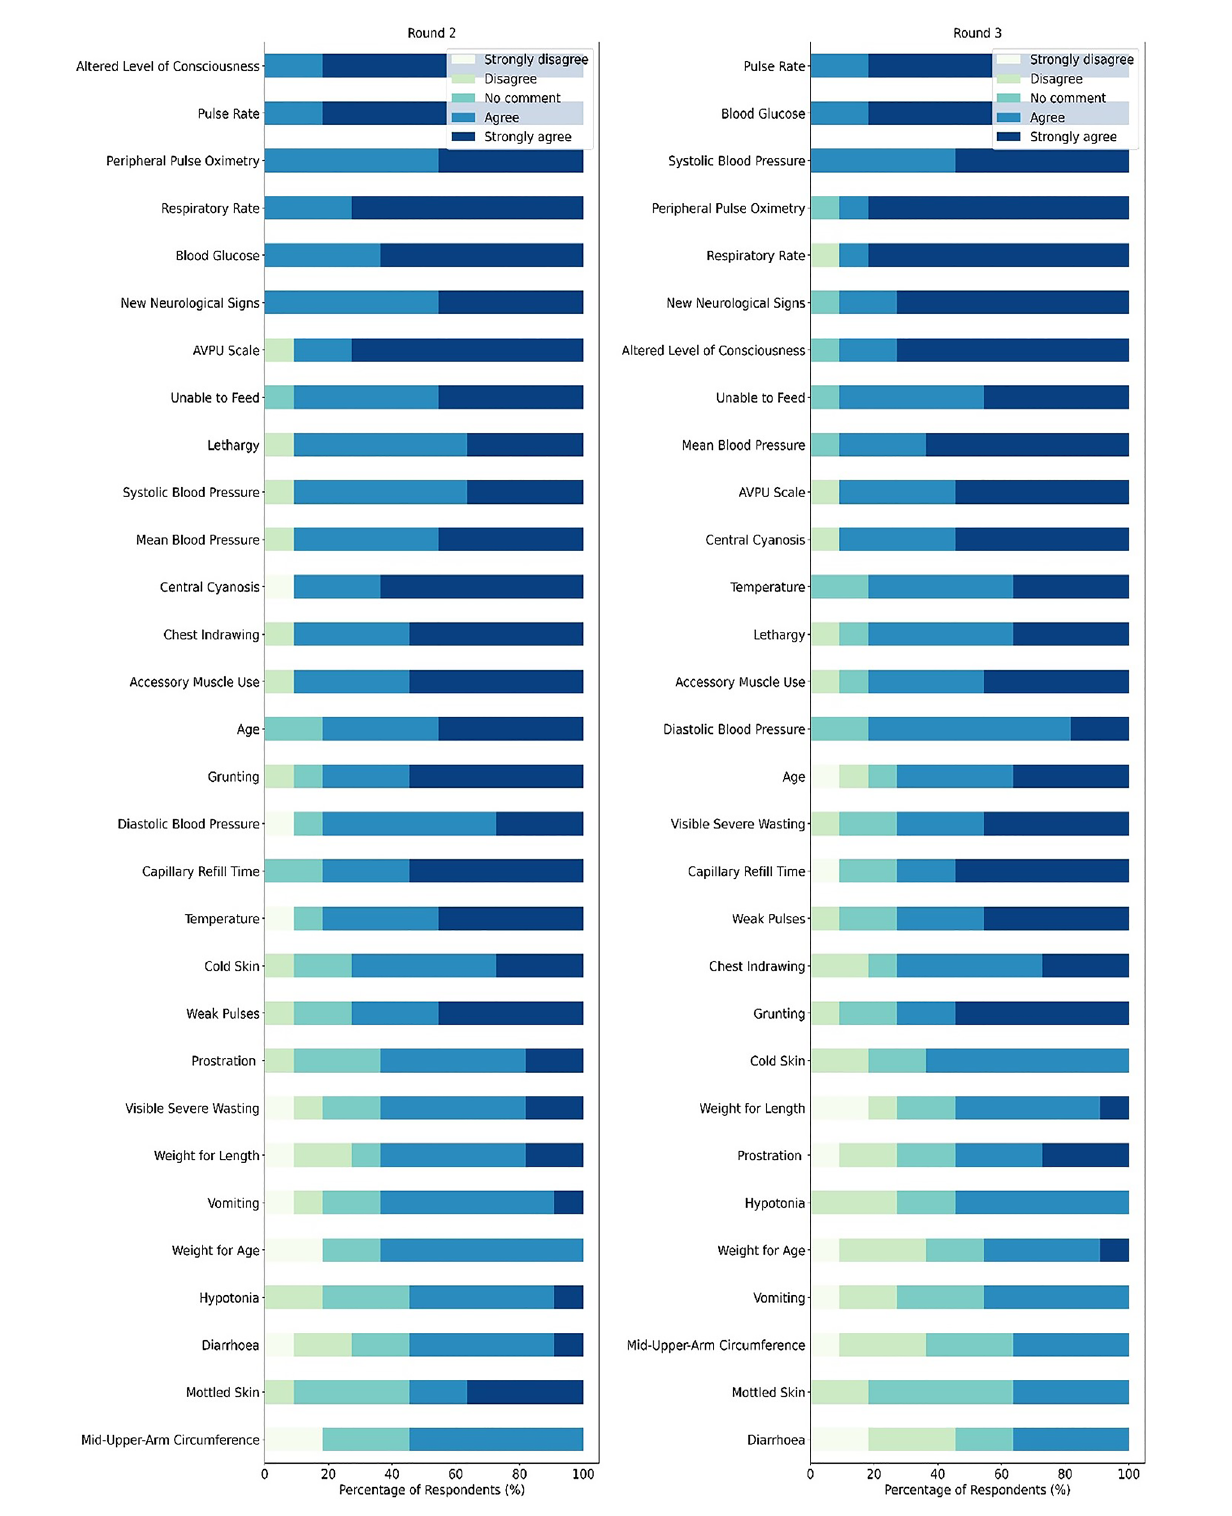
FIGURE 4 Stacked bar plot of agreement on features associated with severe illness in